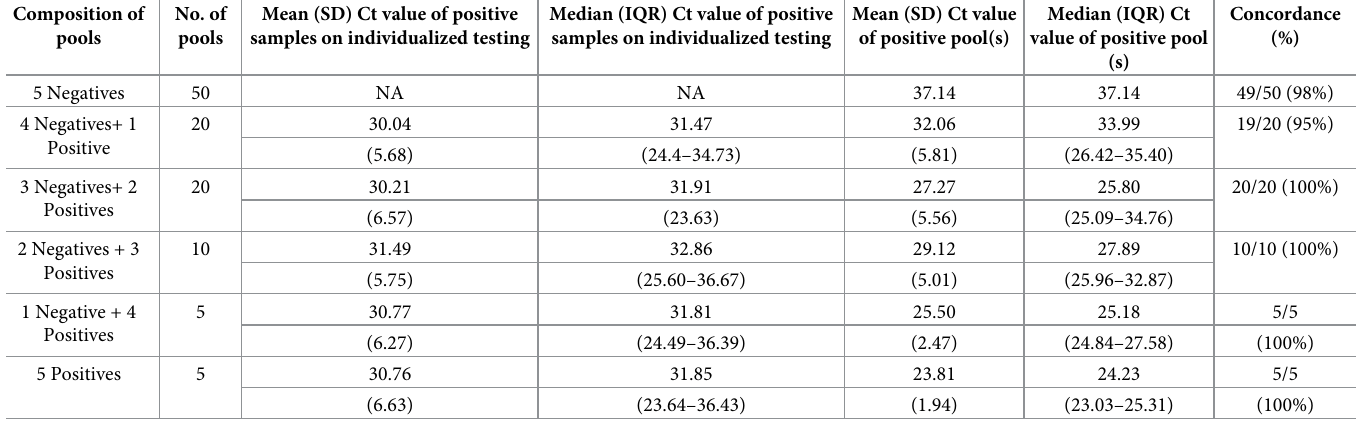
Table 1. Concordance between individualized and simulated pooling strategies, using 5-sample pools. Composition of No. of pools